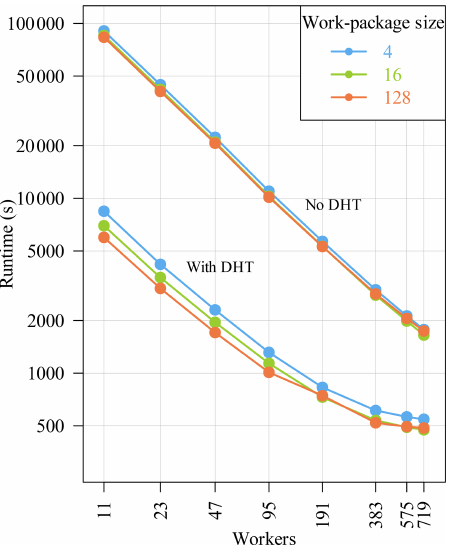
Figure 11. POET ’s runtime with and without DHT activated and for different work package sizes (both axes in log scale).